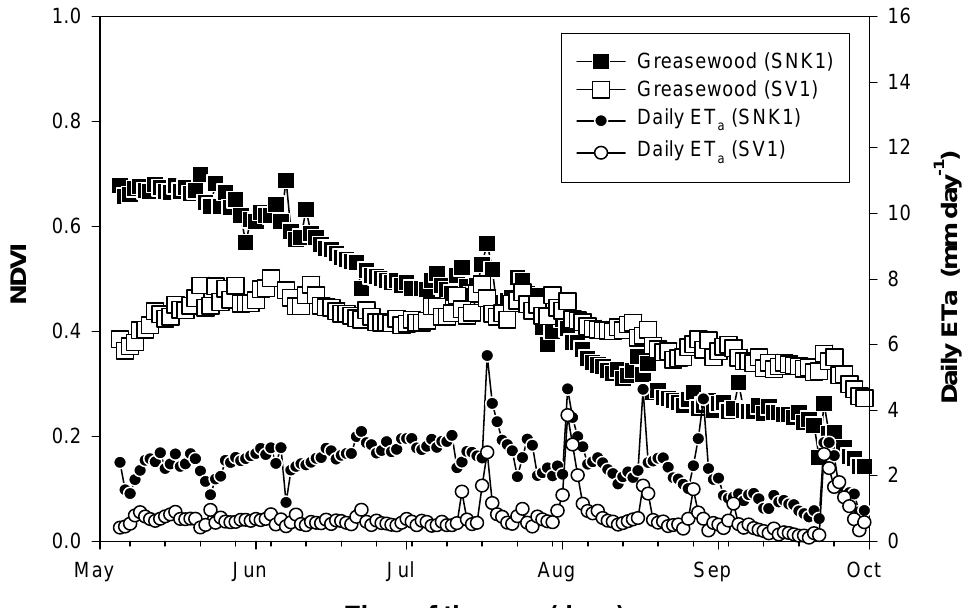
Figure 8. Average midday (11:30–13:30) NDVI values and average daily ET between May 5 and September 30, 2007. Average midday NDVI values are both for a single greasewood plant from the Snake Valley 1 site (closed squares) and from the Spring Valley 1 site (open squares). Average daily ET (closed circles) and from the Spring Valley 1 site (open